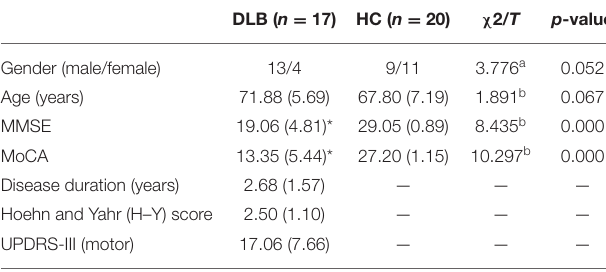
TABLE 1 | Demographic and clinical information of the